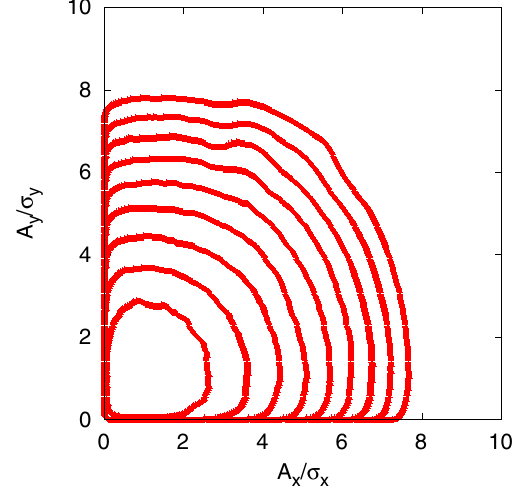
FIG. 4. (Color) Transverse electron distributions without beam- beam interaction ( N p ¼ N e ¼ 0 ). The contour lines are spaced by a factor